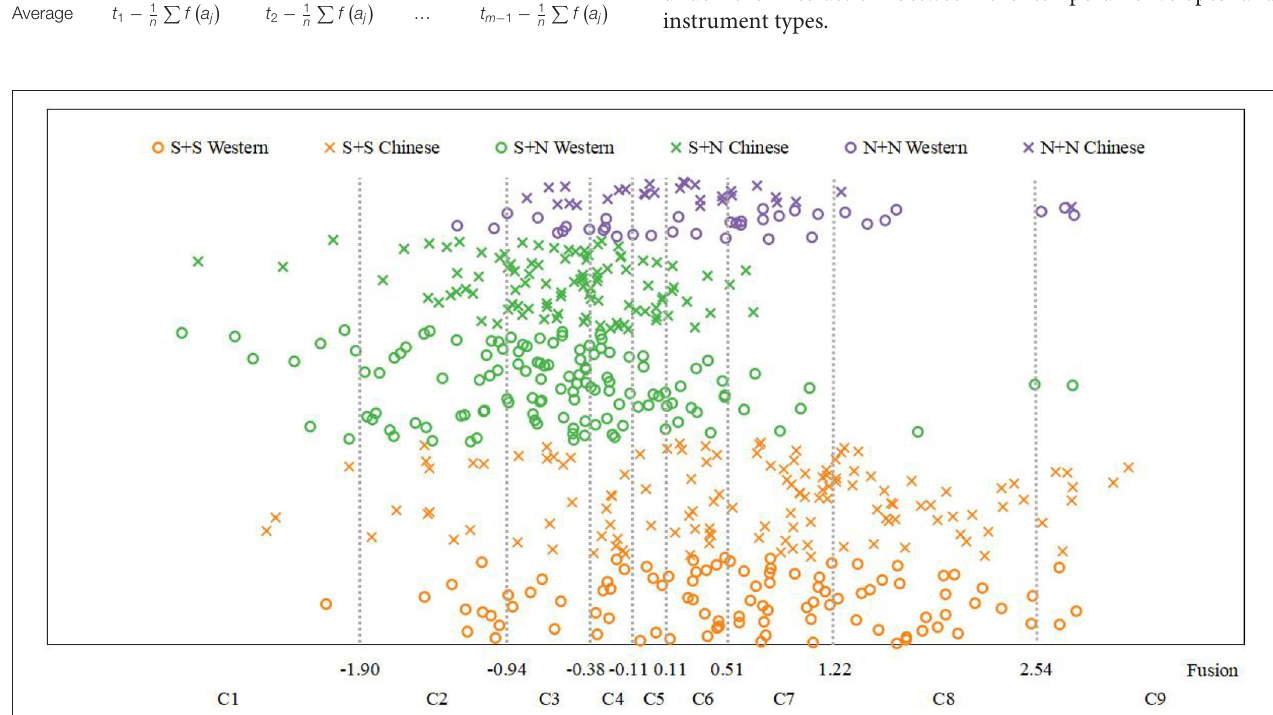
FIGURE 4 | Fusion psychological